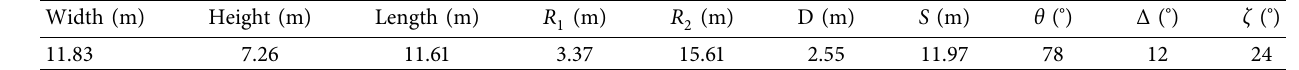
Table 1: Geometric parameters of quasirectangular shield.